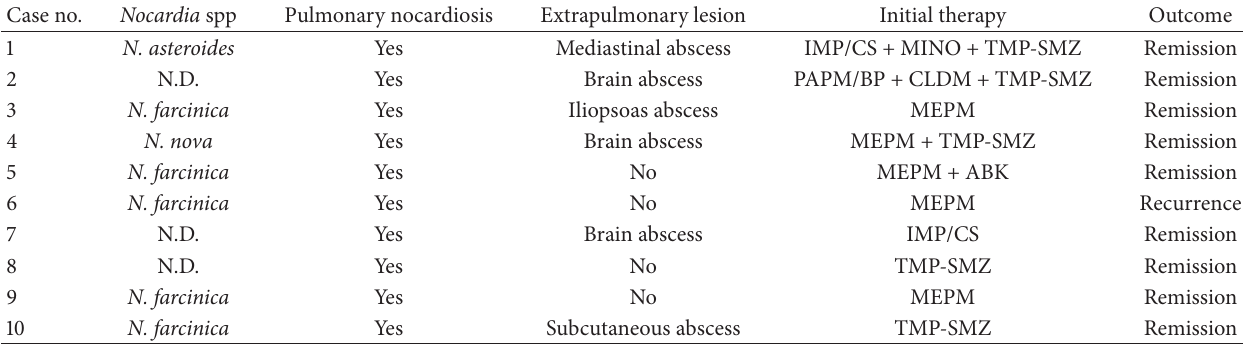
Table 3: Characteristics of Nocardia infection developed in rheumatic disease